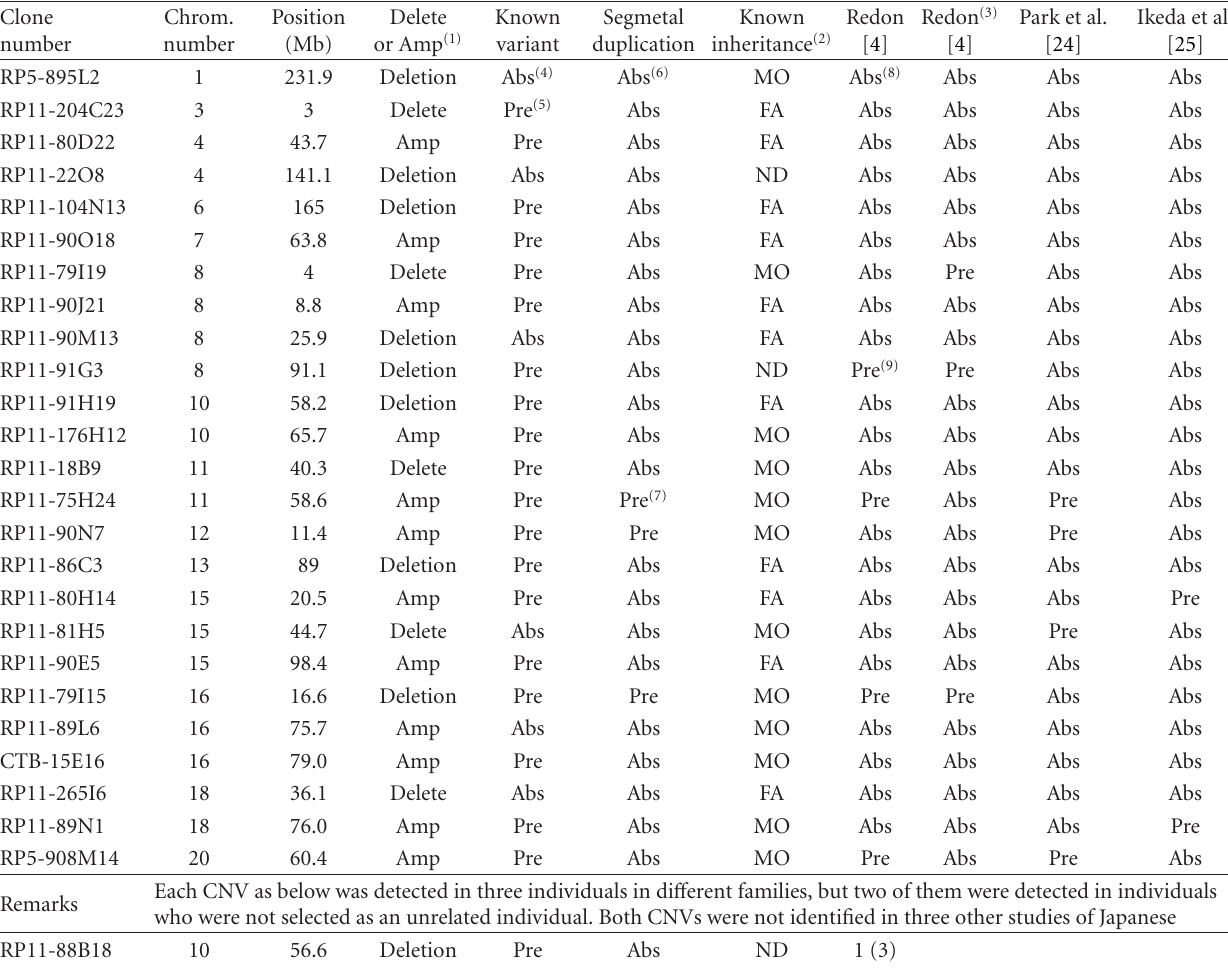
Table 2: Summary of the CNVs detected in single unrelated